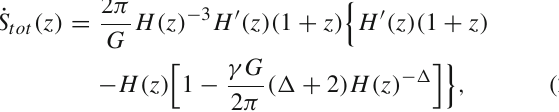
= 0 . 30 and m 0 = c = 1 = H = 1 B 0